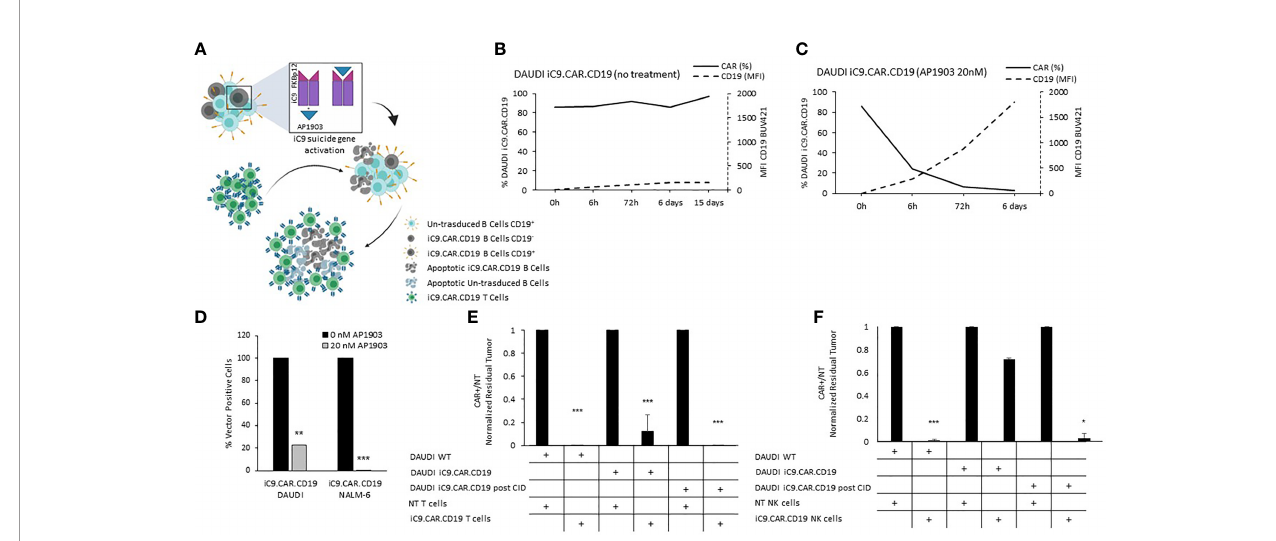
FIGURE 1 | iC9 activation in iC9.CAR.CD19 lymphoma cells leads to prompt elimination of the CAR+ fraction and redetection of CD19 antigen. (A) Schematic representation of iC9 dimerization in iC9.CAR.CD19 lymphoma cells leading to iC9.CAR.CD19 B cells apoptosis and to redetection of CD19 antigen by iC9.CAR.CD19 T cells (created with BioRender.com). (B, C) iC9.CAR.CD19 DAUDI cells were treated with 0 nM (B) and 20 nM (C) of AP1903; both CAR and CD19 expressions were monitored over time by fl ow cytometry. (D) Detection of iC9.CAR.CD19 vector in tumor cells by qRT-PCR after AP1903 exposure. Reactions were performed in triplicate. Black histograms represent the positive control of reference (0 nM of AP1903), and gray histograms represent results after drug exposure (20 nM of AP1903). (E) A 7-day co-culture assay was carried out using un-transduced T cells or iC9.CAR.CD19 T cells and WT DAUDI cells, iC9.CAR.CD19 DAUDI cells never exposed to AP1903, and iC9.CAR.CD19 DAUDI residual after AP1903 exposure and further re-expanded (at effector/target ratio of 1:1). (F) A 7-day co-culture assay was carried out using un-transduced NK cells or iC9.CAR.CD19 NK cells and WT DAUDI cells, iC9.CAR.CD19 DAUDI cells never exposed to AP1903, and iC9.CAR.CD19 DAUDI residual after AP1903 exposure and further re-expanded (at effector/target ratio of 1:1) *p-value ≤ 0.05, **p-value ≤ 0.01, ***p-value ≤